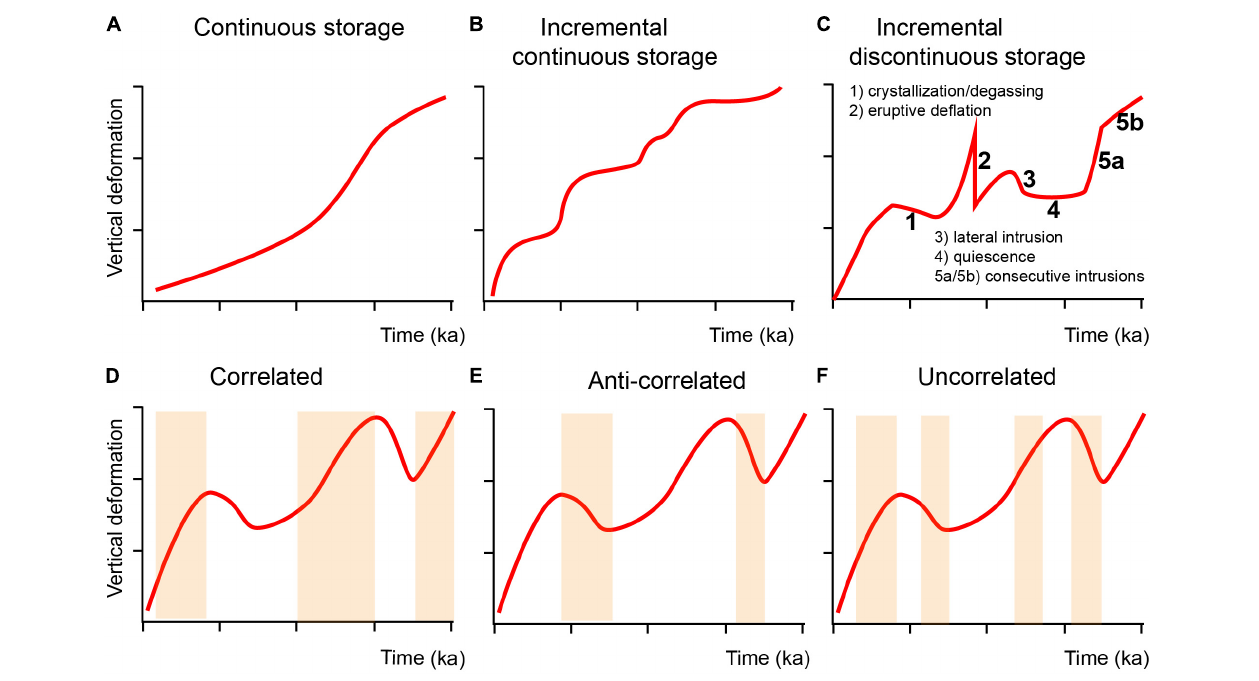
FIGURE 2 | (A–C) Possible evolutionary models for resurgence. The incremental discontinuous storage model is more consistent with available short-term monitoring data: here net uplift is interrupted by stasis (quiescence) or even subsidence, due to crystallization/degassing, eruptions or lateral intrusions. (D–E) Possible relationships between uplift (as resulting from magma intrusion) and eruptive activity (eruptive epochs are highlighted by orange bands) during resurgence. The case of Campi Flegrei ( Figure 1H ) highlights a correlation between magma intrusion and eruption; however, most resurgent calderas would show an anti-correlation, or simply a non-correlation (Galetto et al.,